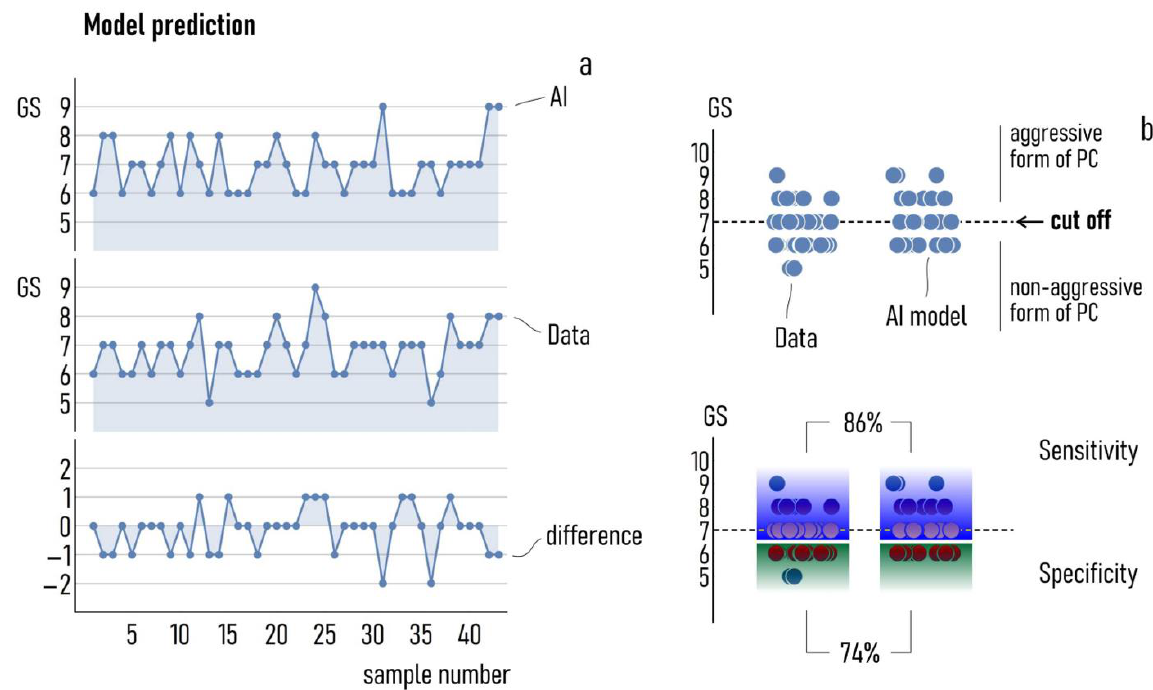
Figure 3. The prediction of the AI model on a cohort of 43 patients used as a validation set compared to the true values of GS measured from those patients ( a ). Using a cut-off value of 7, the model achieved 86% sensitivity and 74% specificity ( b ).